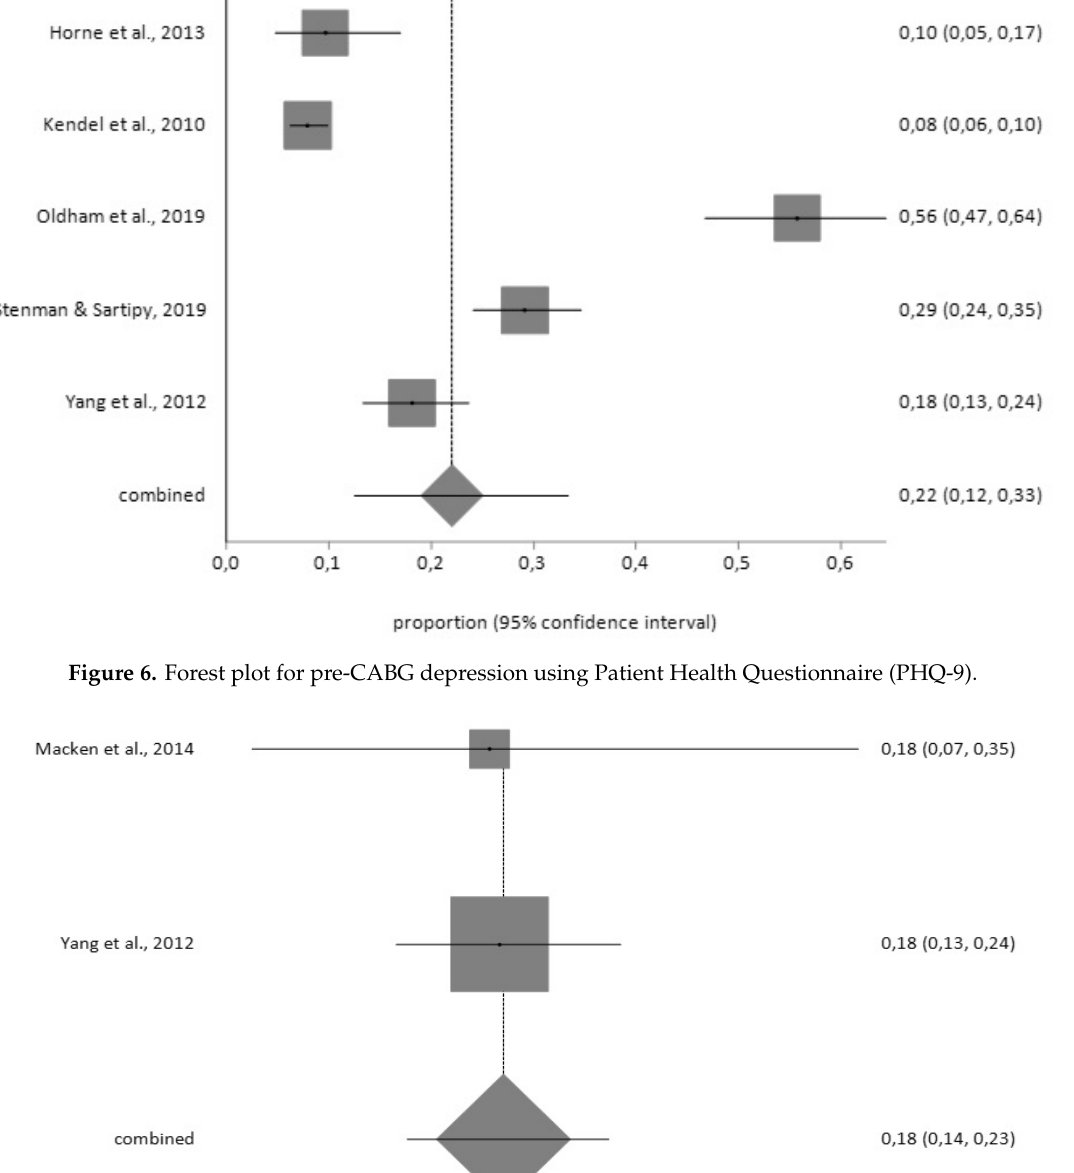
Figure 8. Forest plot for pre-CABG depression using Centre for Epidemiological Studies Depression Scale (CES-D).